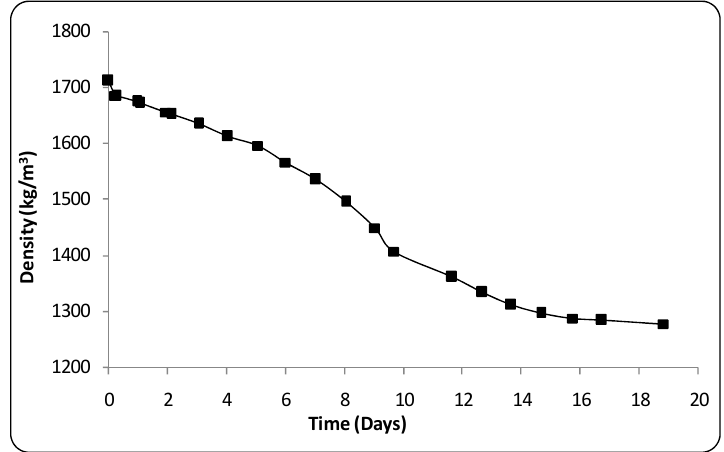
Figure 10. Gypsum plaster density as function of time.